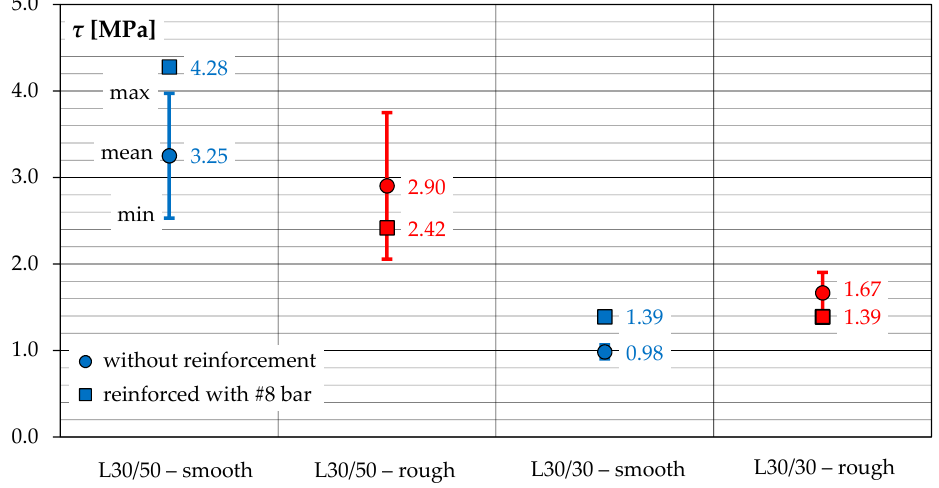
Figure 17. Shear stress at peak load corresponding to specimens of the subsequent test series.